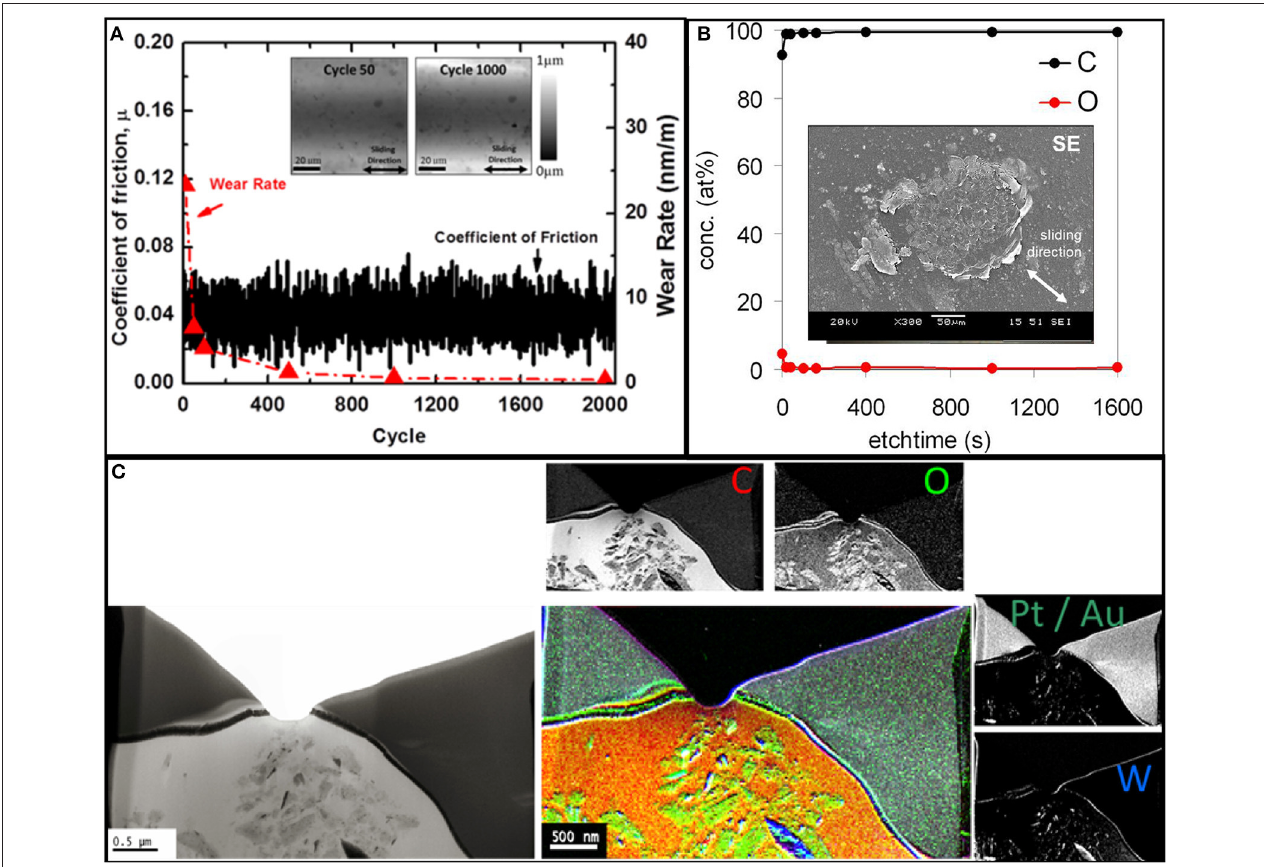
FIGURE 4 | (A) Coefficient of friction and wear rate vs. cycle for diamond sliding against tungsten under hexadecane-lubricated conditions. The inserts show images of the wear track after 50 and 1,000 cycles obtained using the on-line tribometer. Chemical analysis of the worn diamond surface with (B) showing an X-ray photoelectron spectroscopy (XPS) depth profile of the worn diamond surface with an SEM inset of the diamond surface after sliding. (C) Electron energy loss spectroscopy (EELS) analysis of a wear material particle on the diamond counter surface generated during